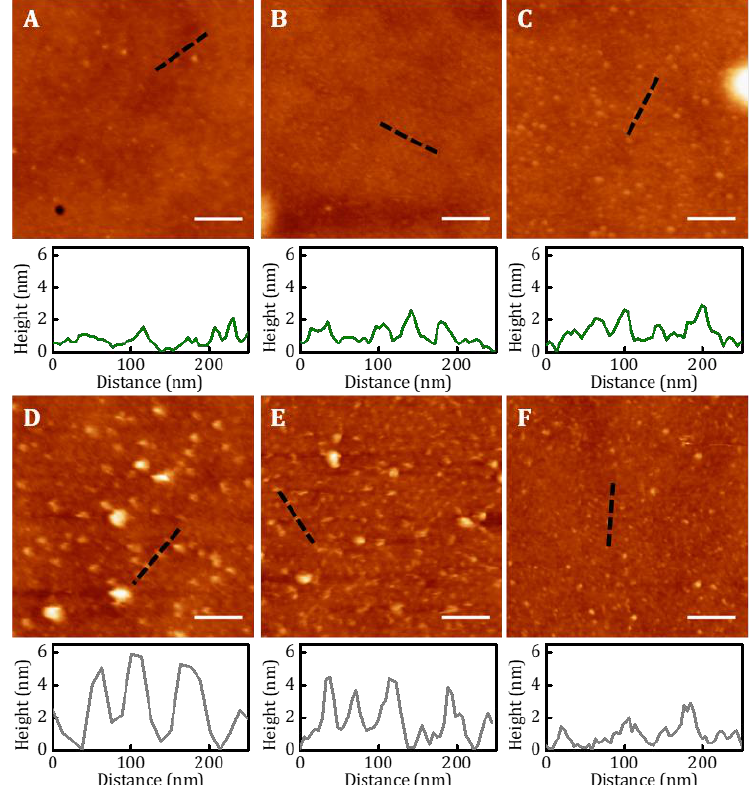
Figure 5. AFM topography images and height profiles (along the black dashed lines) of physically adsorbed and covalently-bound cyclic(RGDfK)-PEG 3 -NH 2 peptides on hydrolyzed diblock copolymer and random copolymer thin films. Images were acquired in liquid conditions. ( A ) Physical adsorption on PS-b-PMMA 123-35, ( B ) on PS-b-PMMA 46-21, and ( C ) on PS-r-PMMA thin films. ( D ) Covalently bound peptides on PS-b-PMMA 123-35, ( E ) on PS-b-PMMA 46-21, and ( F ) on PS-r-PMMA thin films. Scale bar 200 nm; Z-scale: 20 nm.